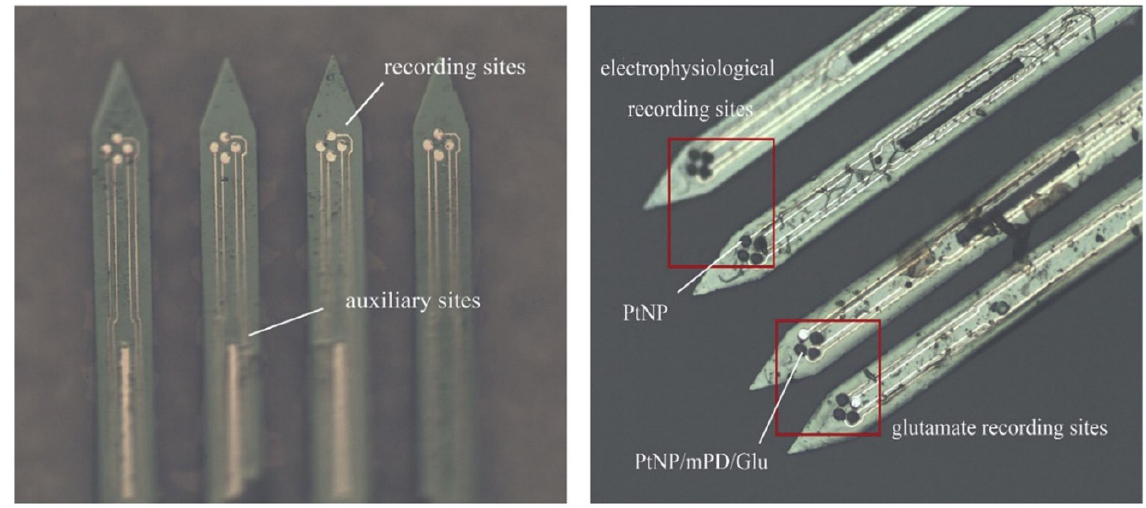
Figure 9. The electrode structure and site distribution.